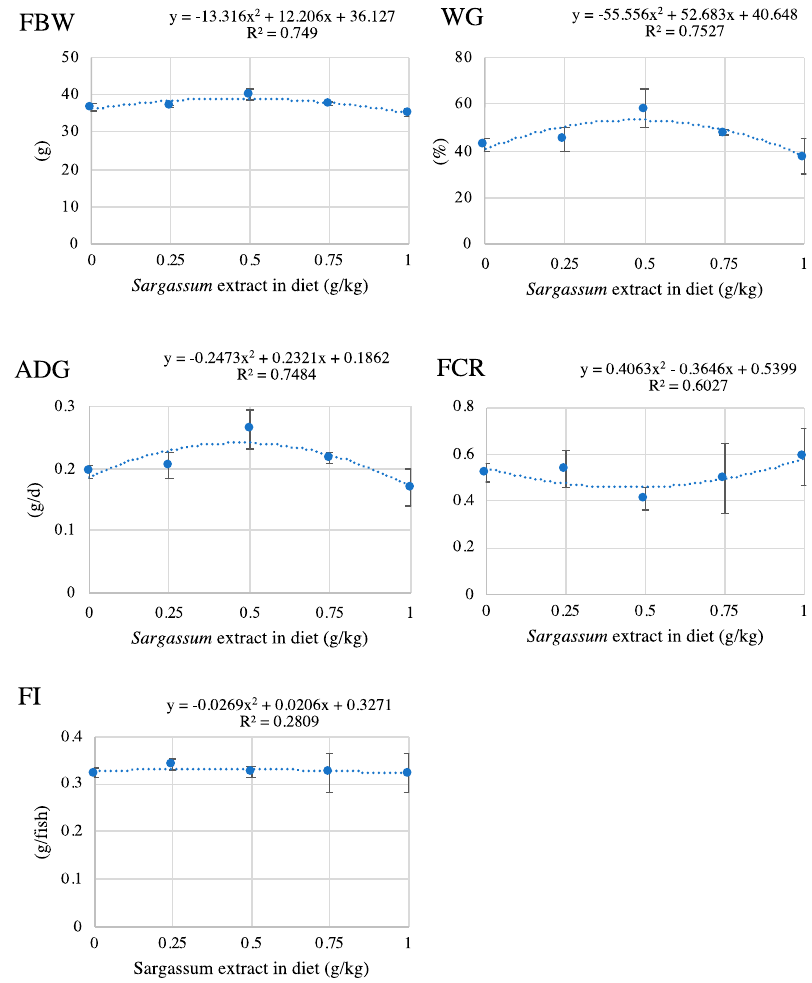
Figure 1. Determination of the optimum supplementation levels of Sargassum extracts in terms of final body weight (FBW), weight gain (WG), average daily growth (ADG), feed intake (FI), and protein efficiency ratio (PER) in 8-week feeding trial.